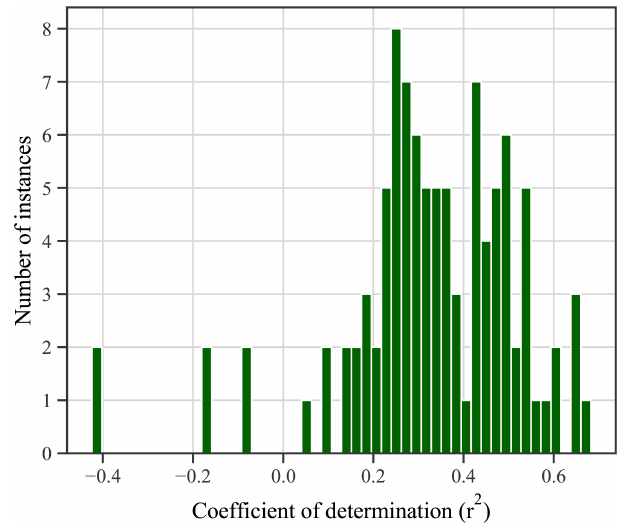
Figure 5. Histogram of results for the random state